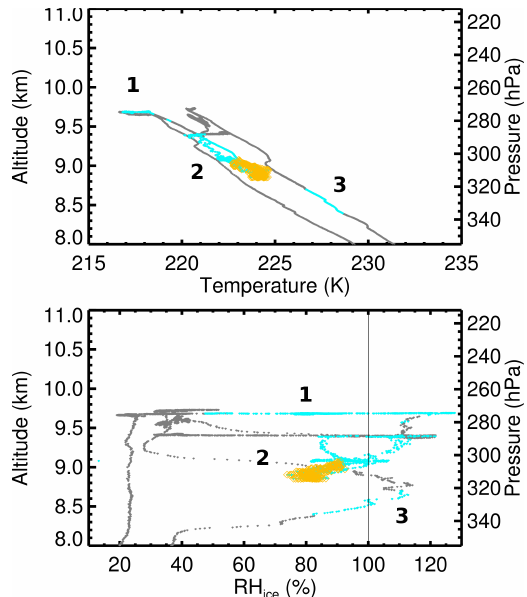
Nov. 17, 2008, including the A340 contrail (coloured by age, see